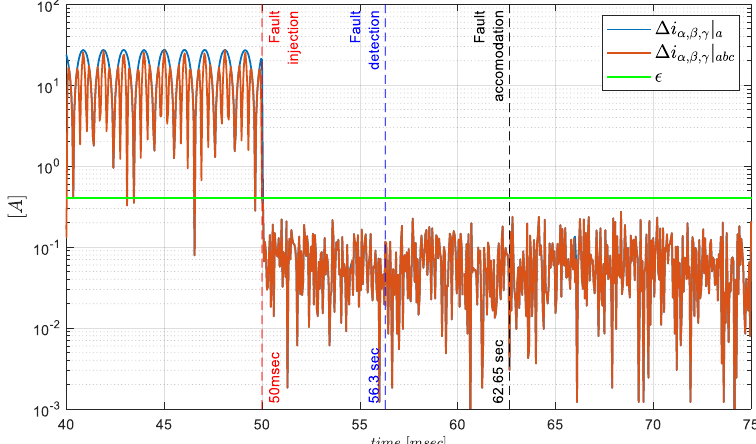
Figure 20. FDI residual current signals and threshold